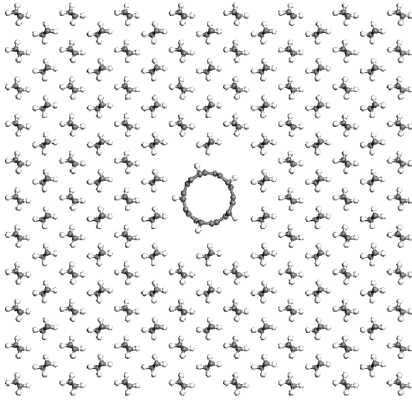
Figure 8: CNT/polyethylene